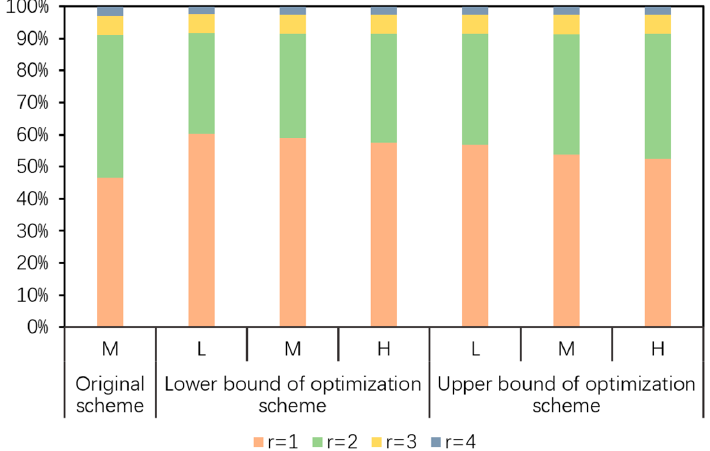
Figure 4. Shares of the carrying capacities of di ff erent regions for rare migratory water birds under di ff erent scenarios. L, M, and H denote low, middle, and high flood flow scenarios, respectively. Table 4. The recovered habitat area in the IPFTSP and IPTSP models under di ff erent flood flow scenarios (10 3